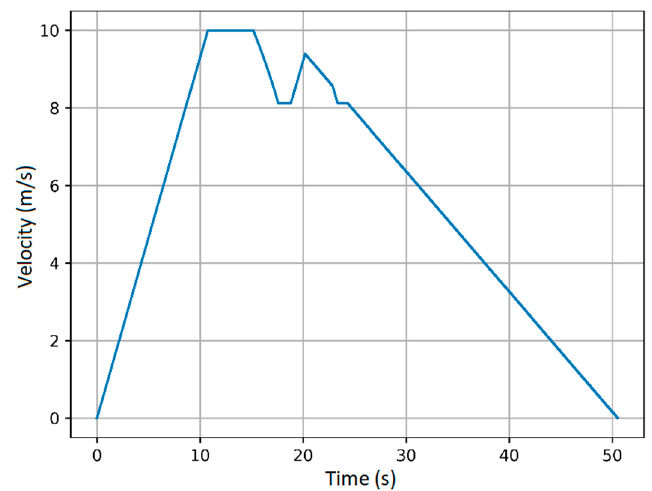
Figure 17. Velocity profile for the example path for the map 3.